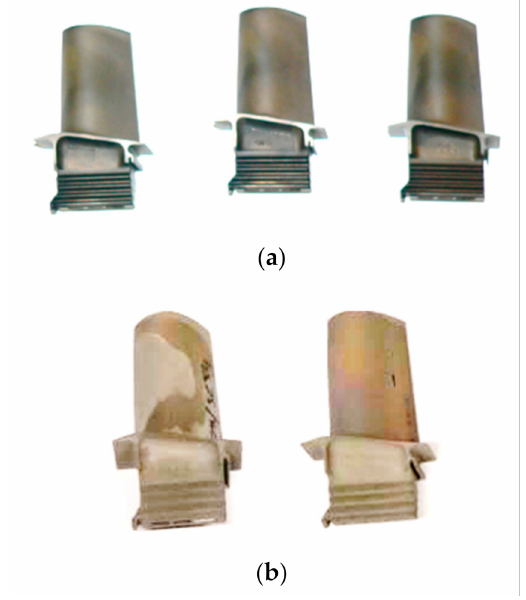
Figure 1. Turbine blades after exploitation for 303 h ( a ) and 473 h ( b ).